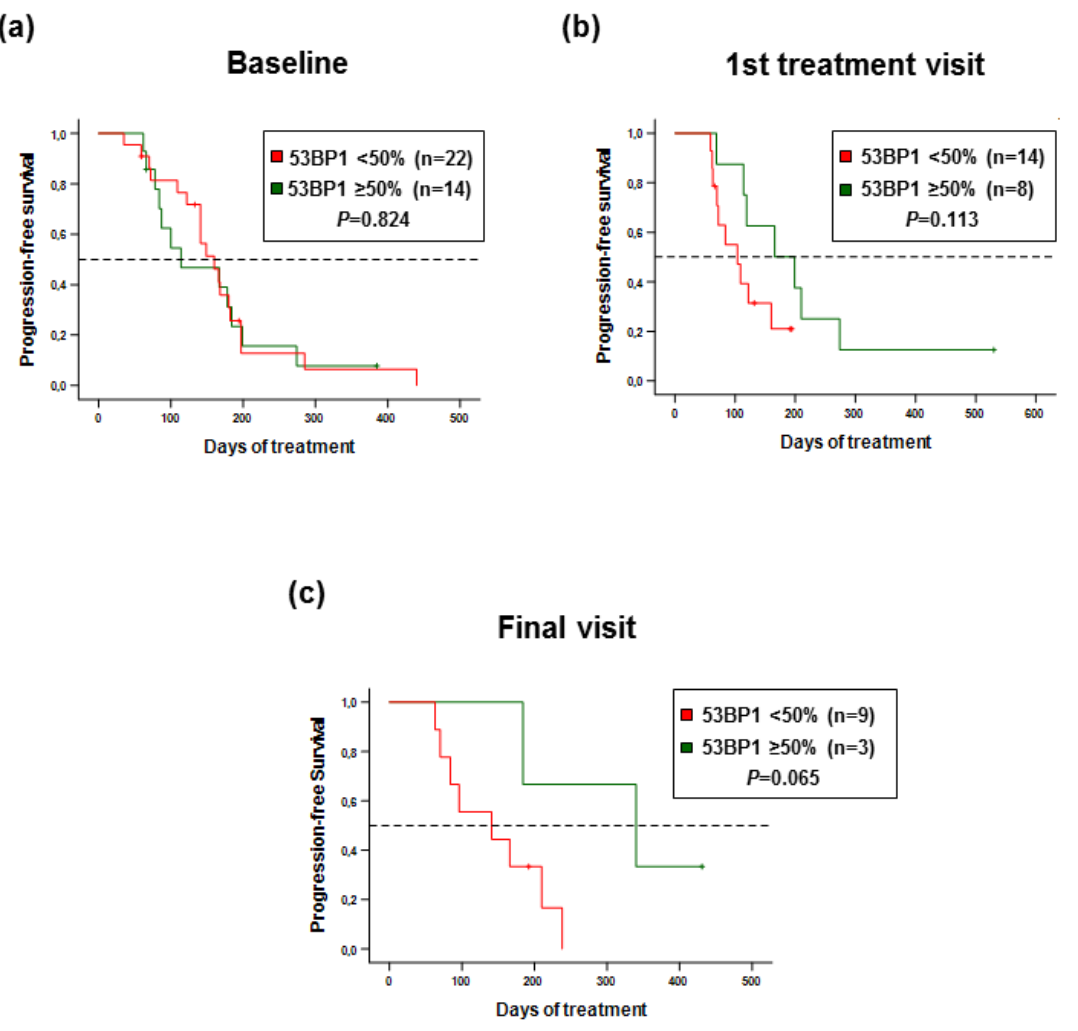
Figure 5. Longitudinal comparison of PFS curves based on 53BP1 status. Progression-free survival (PFS) curves are based on Kaplan-Meier estimates for MBC patients with CTCs showing a 53BP1 score < 50% or ≥ 50%. ( a ) PFS of patients recruited during the baseline visit. ( b ) PFS of patients recruited during the 1st treatment visit. ( c ) PFS of patients recruited during the final visit.